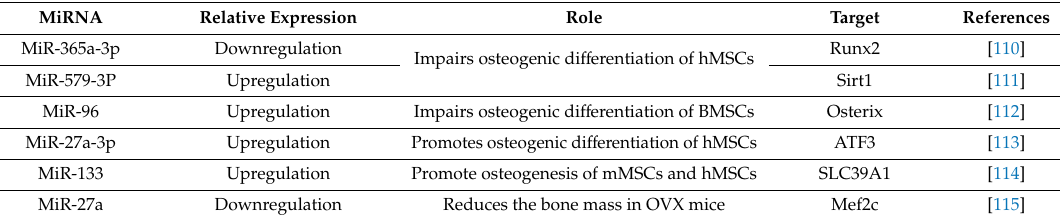
Table 8. Role of miRNAs in osteoporosis